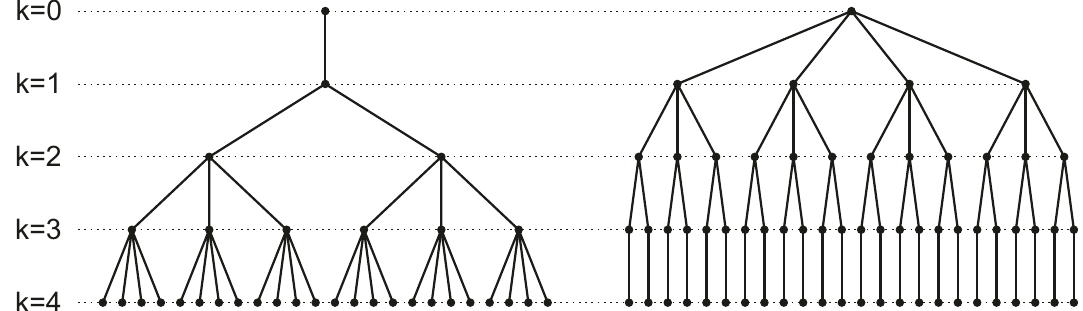
Figure 1 . Super trees: (a) growing tree T + with p 0 branches at the root point and a = 1, (b) descending tree T (cid:0) with p 0 = 4 branches and a = (cid:0)